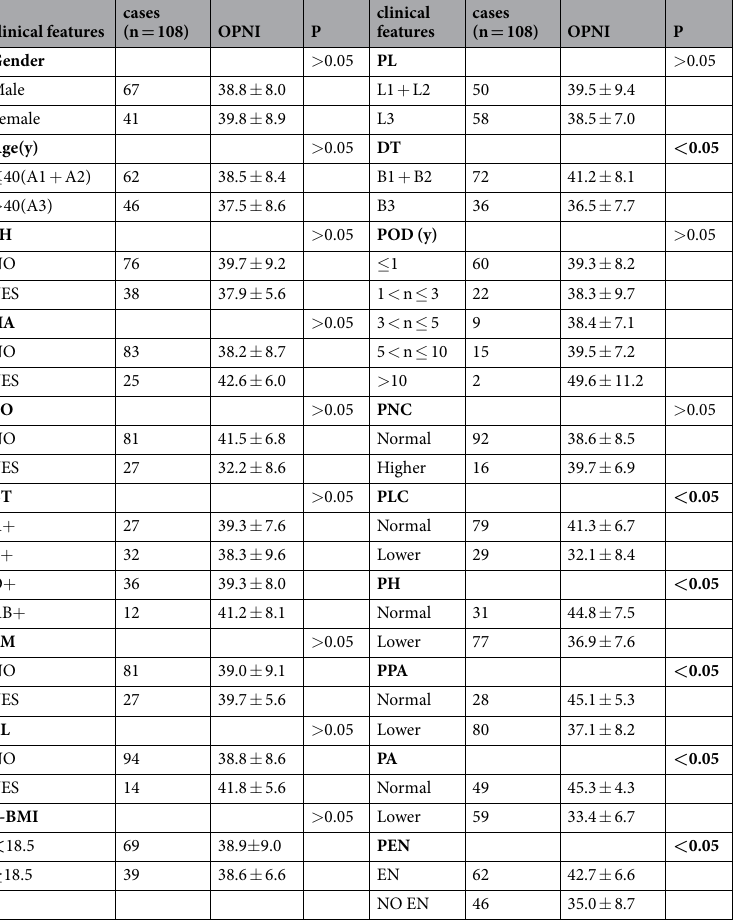
Table 1. Distributions of OPNI according to clinical features. SH , smoking history; HA , history of appendectomy; POD , preoperative duration; PL , primary lesion; DT , disease type (B3 or not); EM , extraintestinal manifestations; PL , perianal lesions; EO , emergency operation; p-BMI , preoperative BMI; BT , blood type; PH , preoperative haemoglobin; PNC , preoperative neutrophil count; PLC , preoperative lymphocyte count; PA , preoperative albumin; PPA , preoperative prealbumin; PEN , preoperative enteral